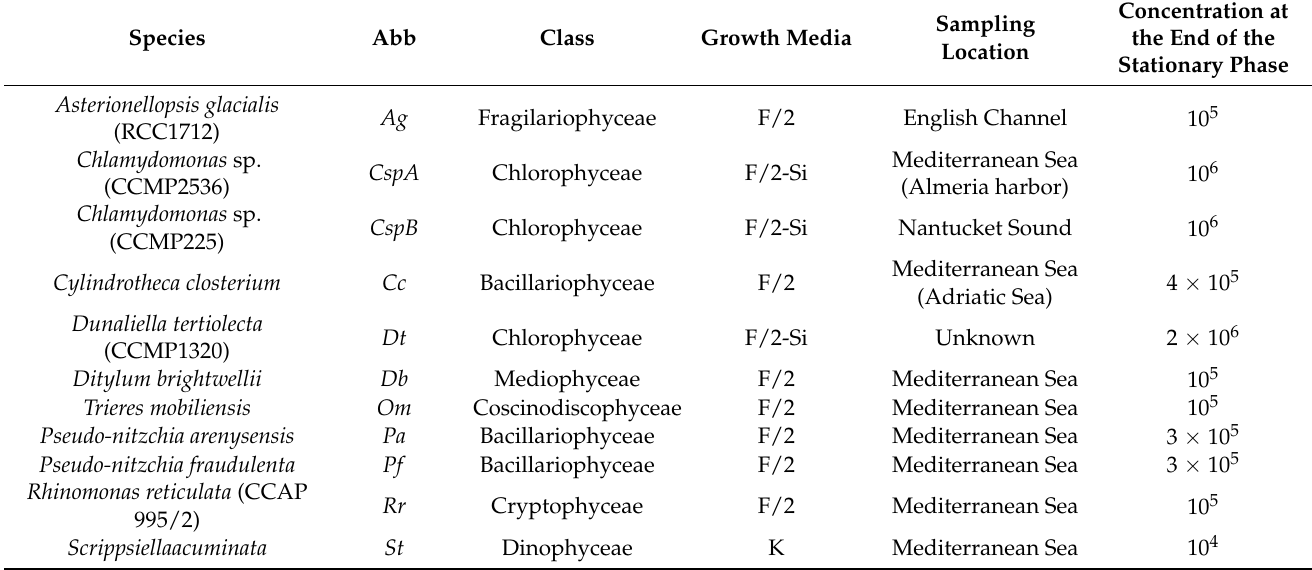
Table 1. The table reports the microalgal species cultured for this study, name abbreviation (Abb), their class, growth media, sampling location and cell concentration at the end of the stationary phase when they were pelleted and stored for the successive